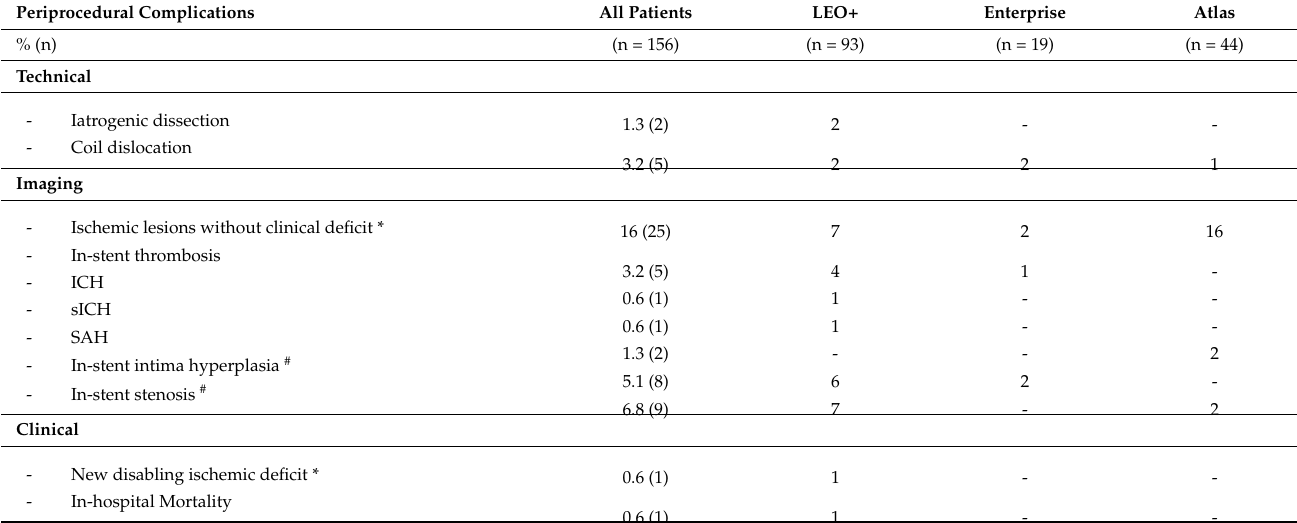
Table 2. Procedural complications of all patients and grouped by stent model.